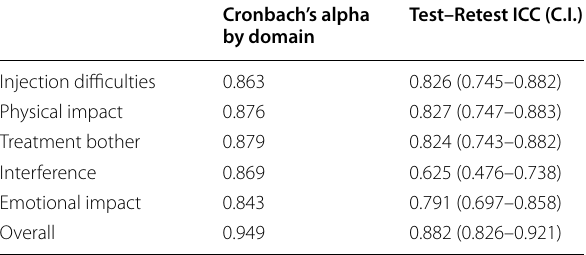
Table 7 Evidence for internal consistency of the